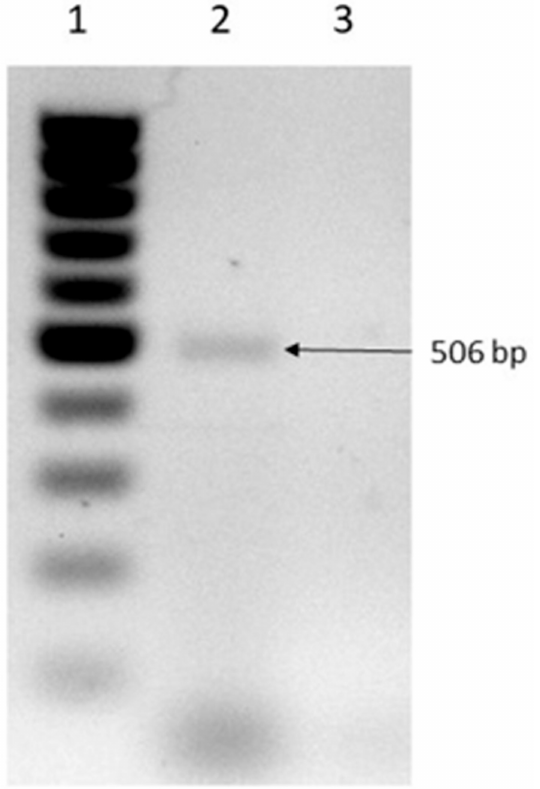
Figure 3. The 18S-ITS1-5.8S-ITS2-25S rRNA gene amplification. Lane 1: Molecular weight marker 100 bp DNA ladder; Lane 2: Liver biopsy sample; Lane 3: Negative